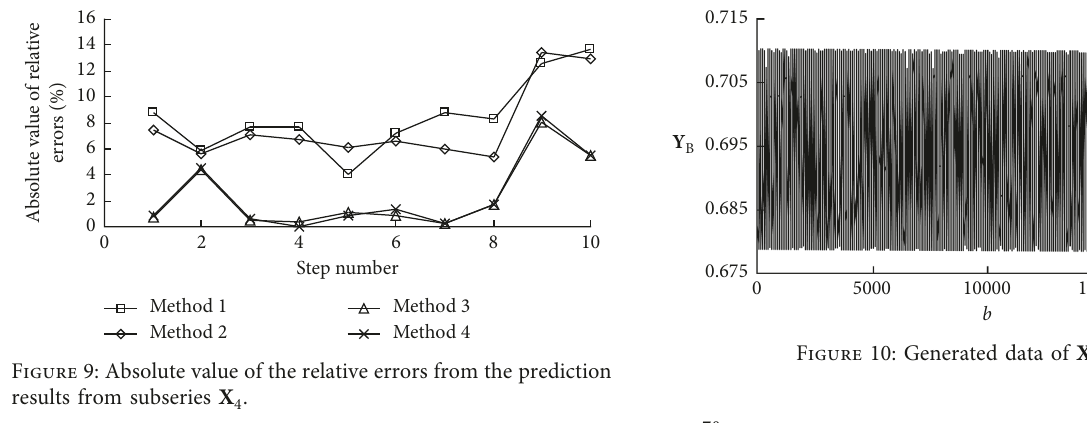
Figure 9: Absolute value of the relative errors from the prediction results from subseries X 4 .